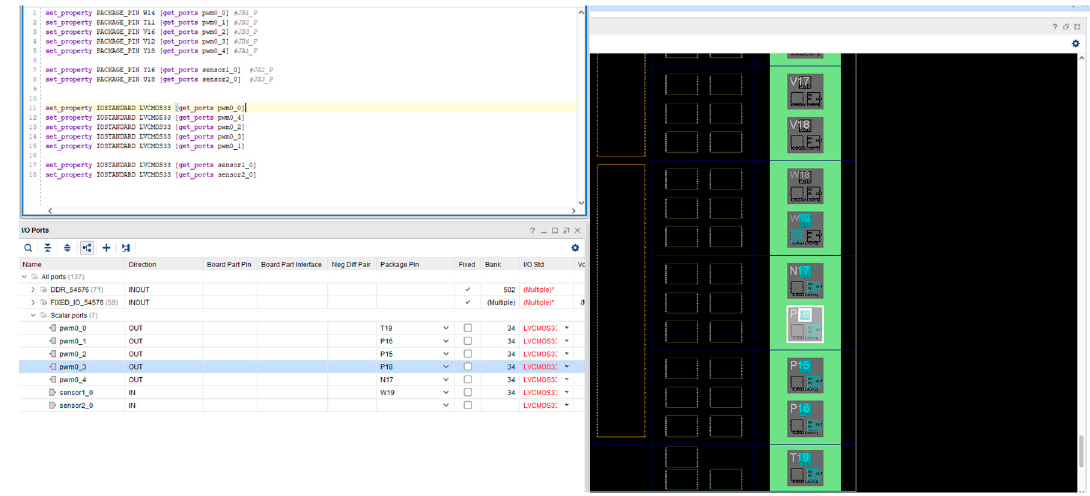
Figure 16. Implementation environment of Hardware mapping.